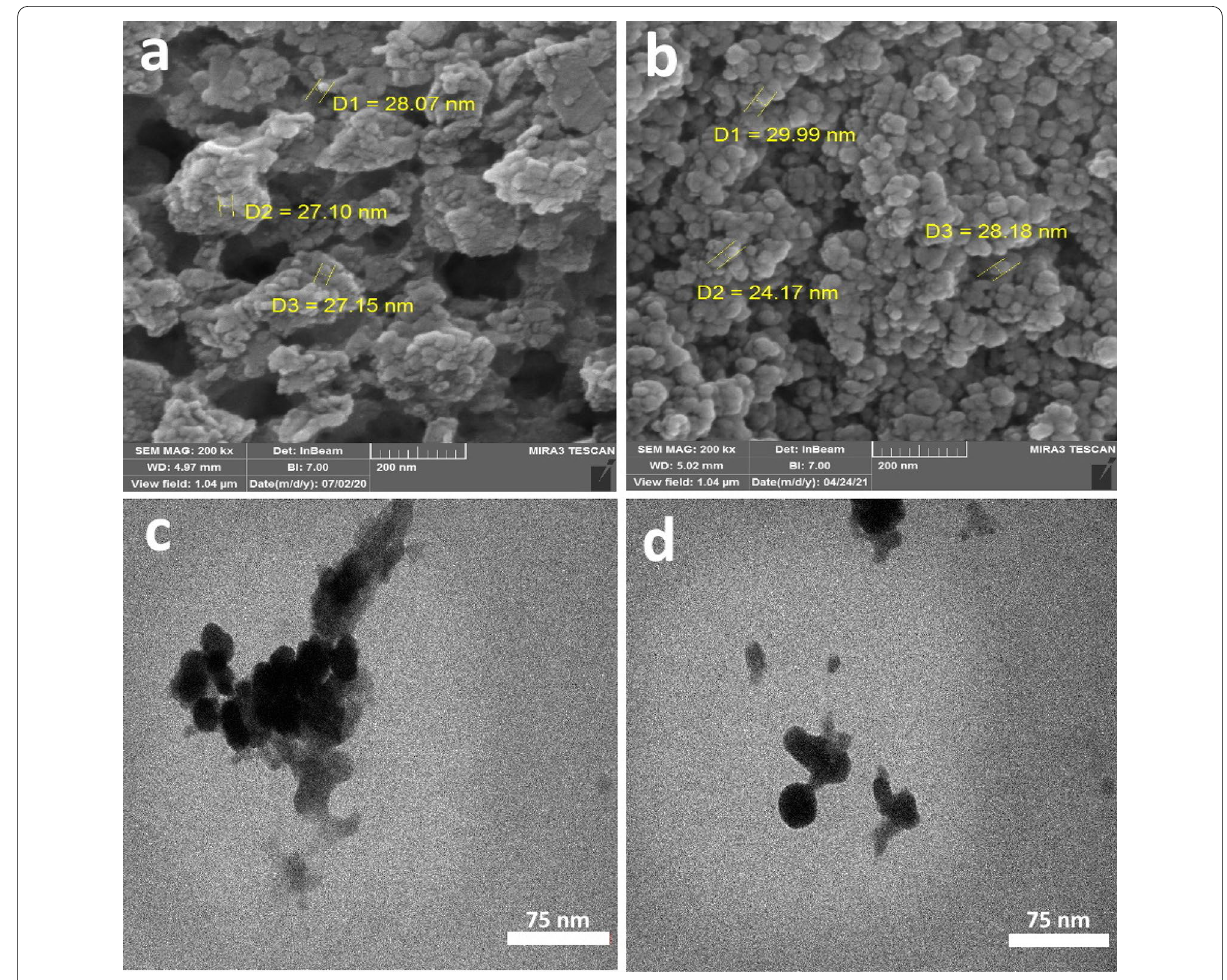
Fig. 3 a , b SEM, c , d TEM images of biosynthesized Ag 2